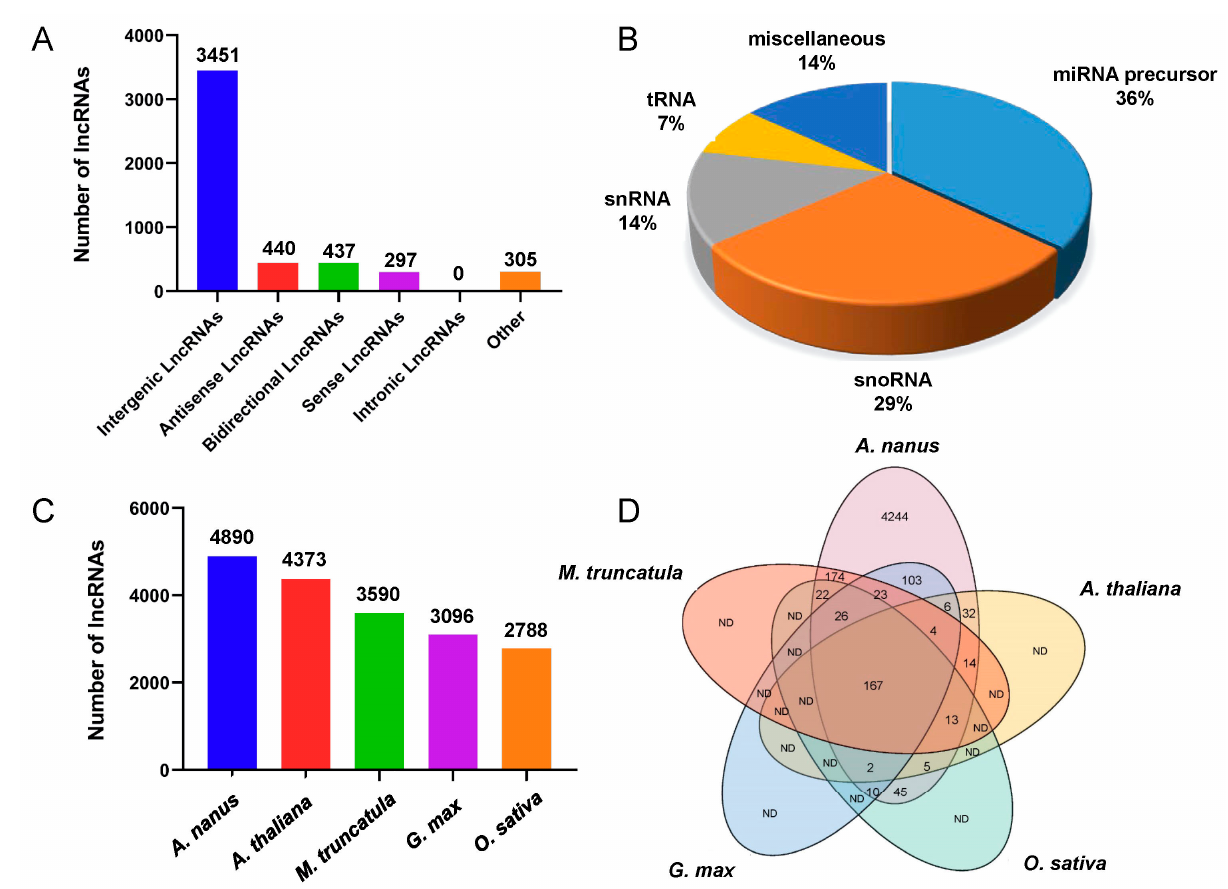
Figure 2. Identification of lncRNAs in A. nanus . ( A ) Classification of the lncRNAs identified in A. nanus according to the locations in the genome. ( B ) Housekeeping ncRNA and miRNA precursors predicted from the six libraries. ( C ) Number of lncRNAs identified from A. nanus , G. max , M. truncatula , A. thaliana , and O. sativa. ( D ) The Venn diagram analysis of lncRNAs identified from A. nanus with those identified from G. max , M. truncatula , A. thaliana , and O. sativa . ND, the number of lncRNAs were not determined.